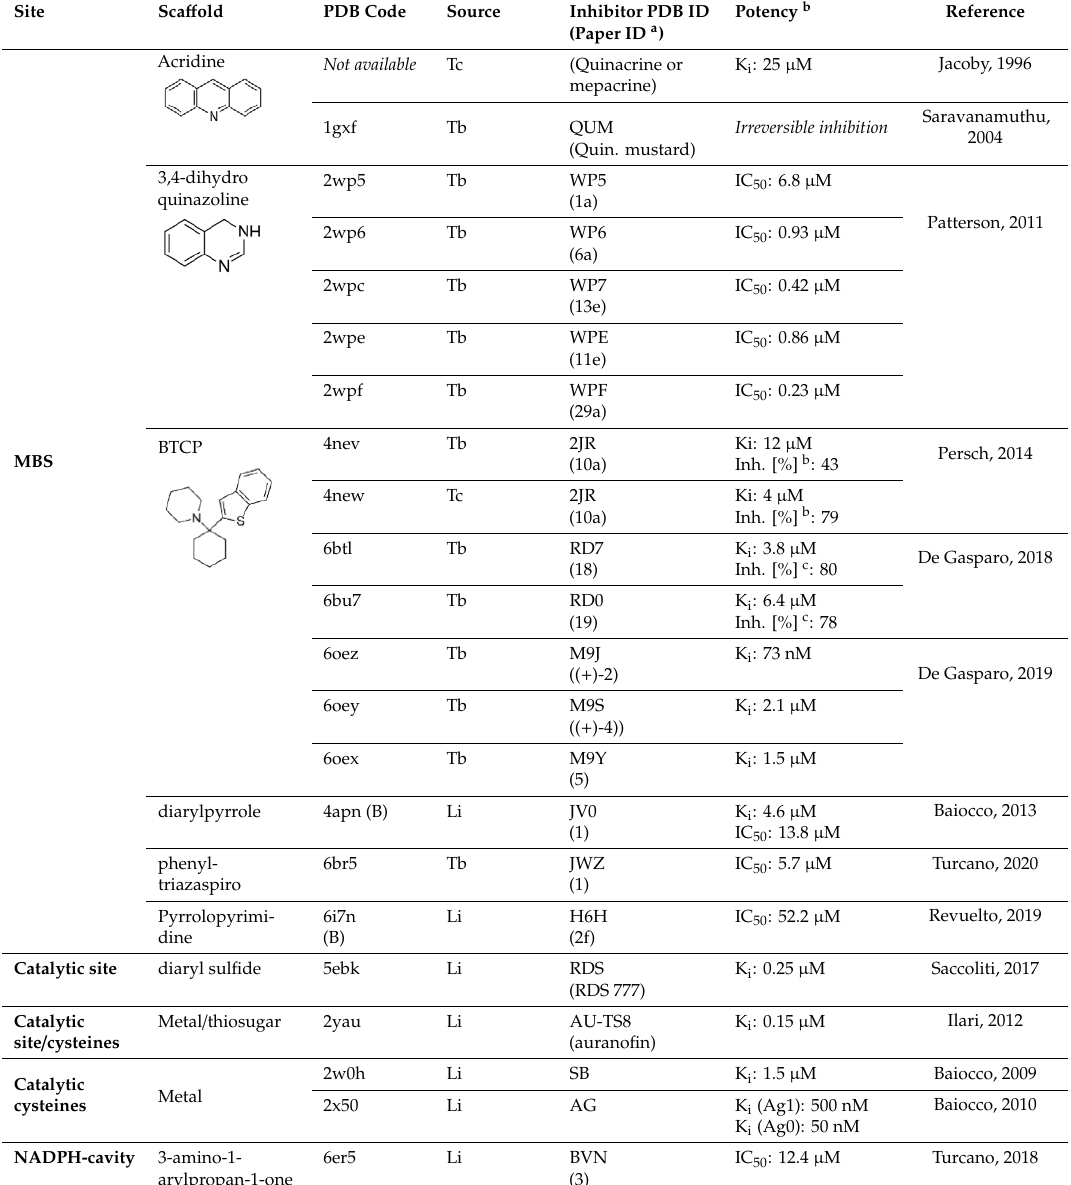
Figure 3. Organic inhibitors co-crystallized with TR, grouped by binding site and molecular scaffold. Molecules are named by PDB 3-digit ID. Table 1. All inhibitors co-crystallized with TR. Table 1. All inhibitors co-crystallized with